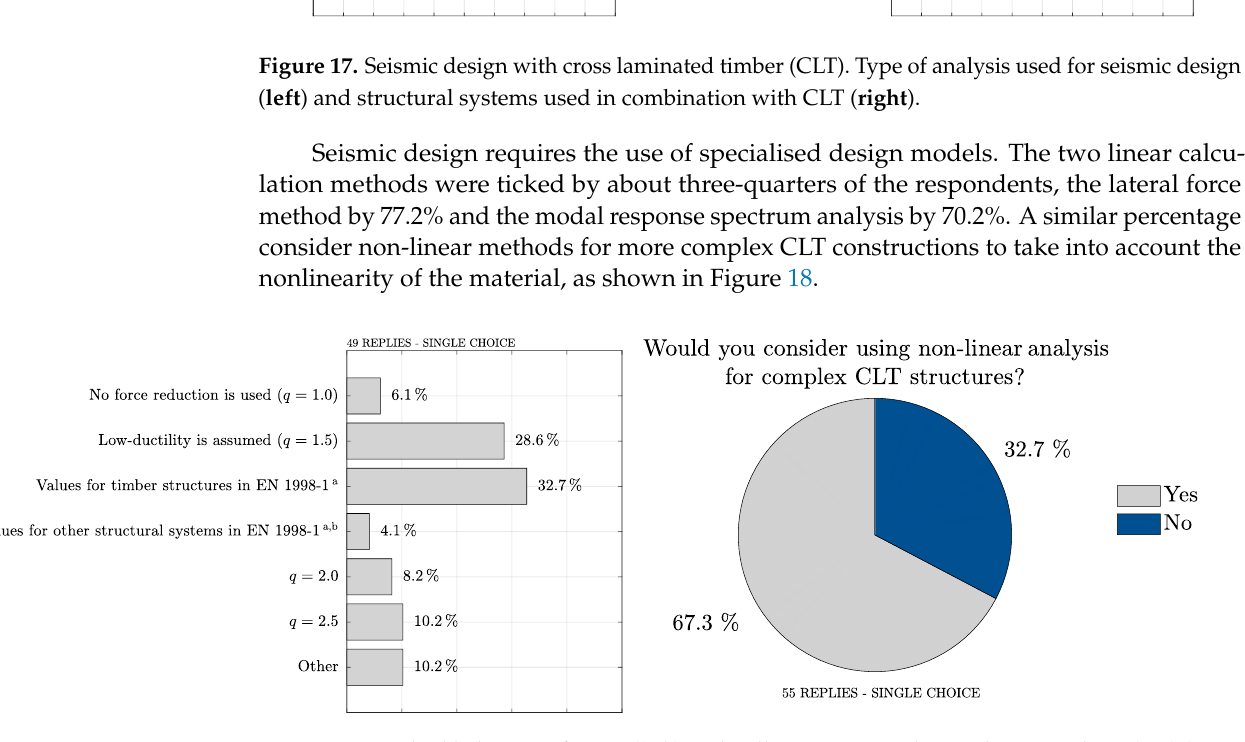
Figure 18. Applied behaviour factors ( left ) and willingness to apply non-linear analysis ( right